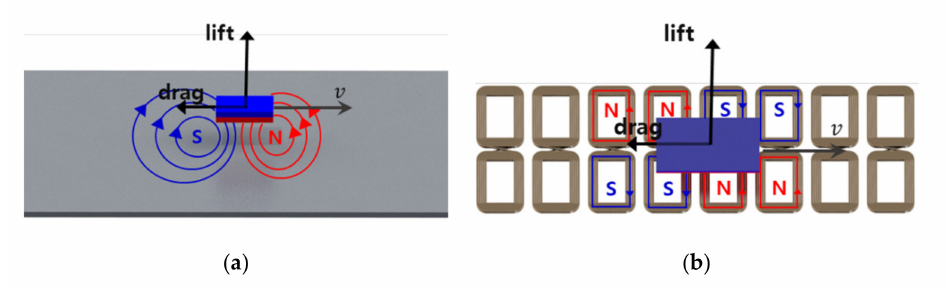
Figure 1. Induced current on two electrodynamic suspension (EDS) track types (Lift and drag forces act on the moving magnet on a ( a ) continuous sheet track and on a ( b ) discrete null-flux coil track).